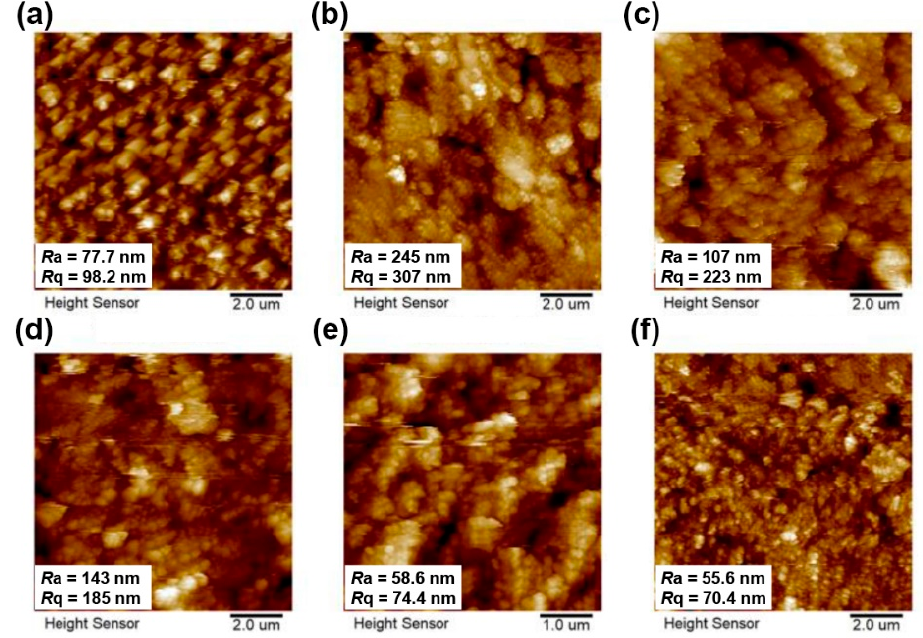
Figure 17. The 2D AFM images (10.0 µ m × 10.0 µ m) of 6FPI-X-AO films after AO exposure. ( a ) 6FPI-0-AO, ( b ) 6FPI-5-AO, ( c ) 6FPI-10-AO, ( d ) 6FPI-15-AO, ( e ) 6FPI-20-AO, ( f ) 6FPI-25-AO. The relative atomic concentrations of the AO-exposed and unexposed films